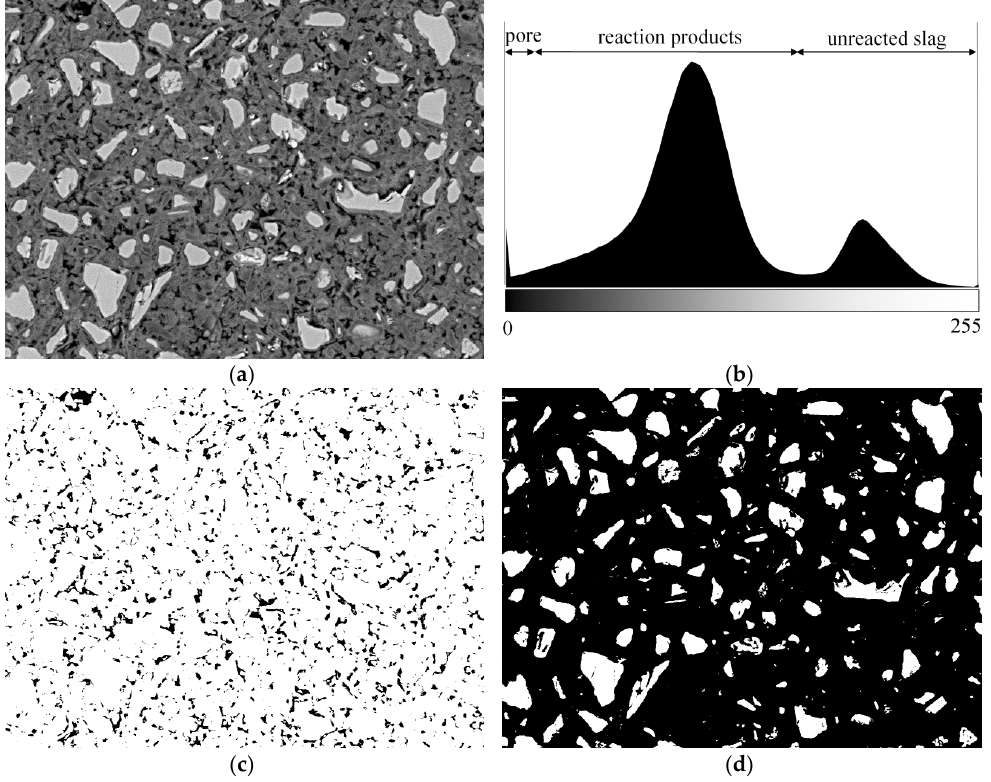
Figure 3. A typical backscattering electron (BSE) image ( a ) with its grey level histogram ( b ), pores ( c ), and unreacted slag ( d ) obtained after applying thresholds on the original BSE image.